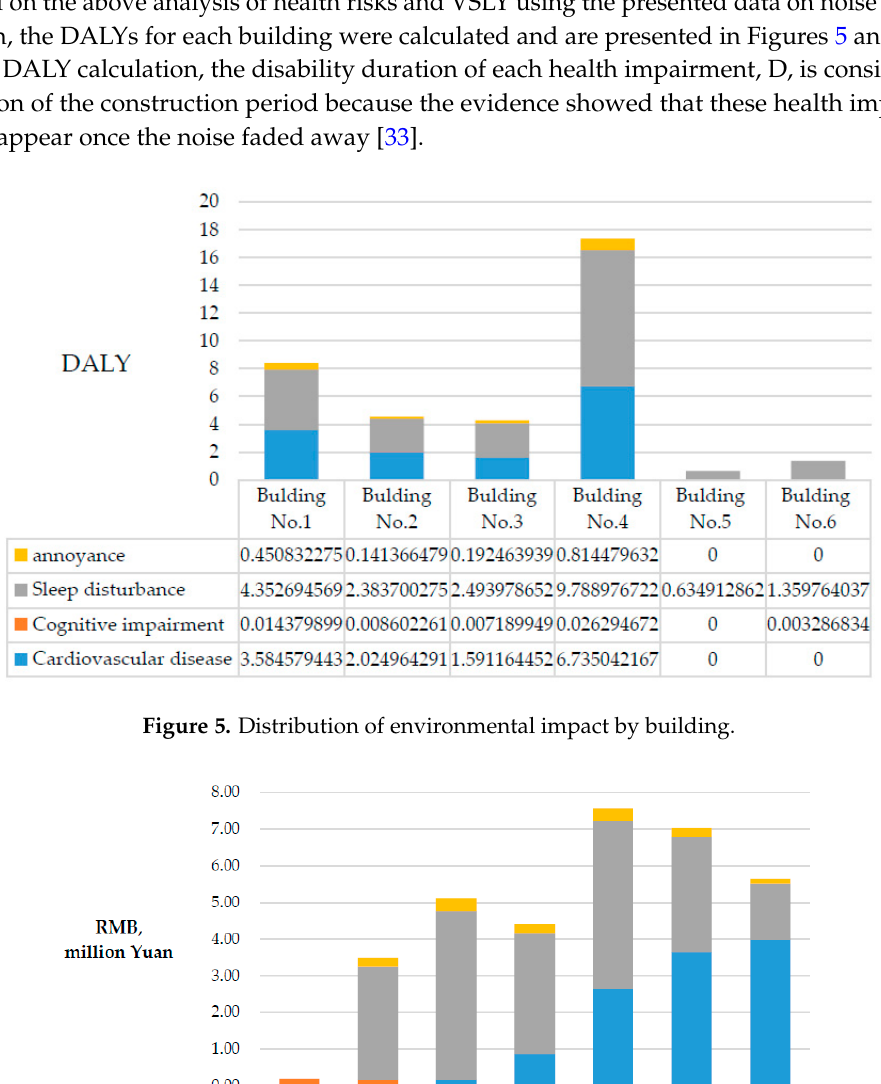
Figure 4. Distribution of age and gender.